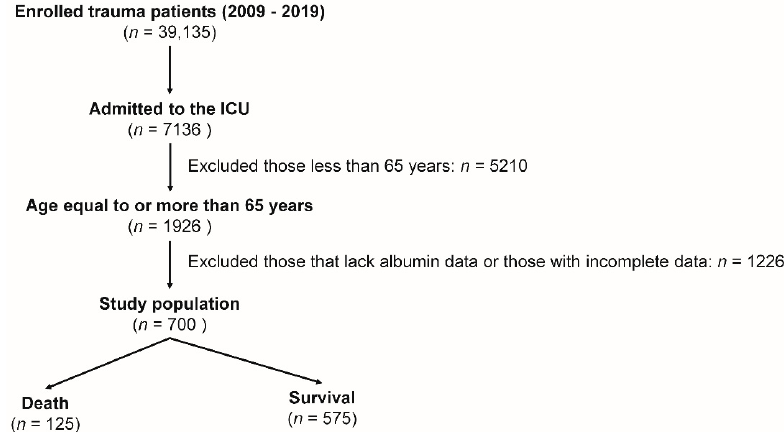
Figure 1. Flow chart illustrating the inclusion of older trauma patients in the ICU and the allocation of these patients into the mortality group and survival group.